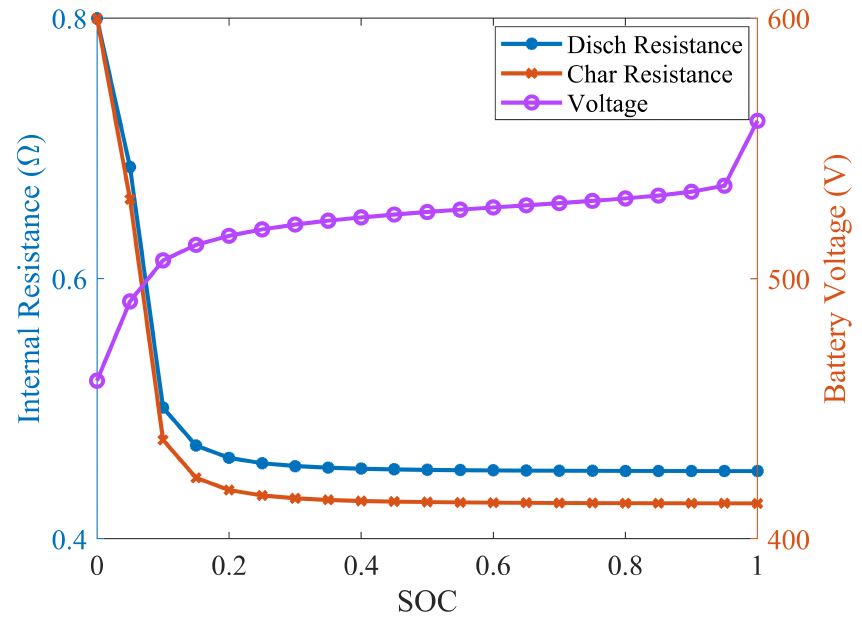
Figure 4. The characteristic parameters of the single battery